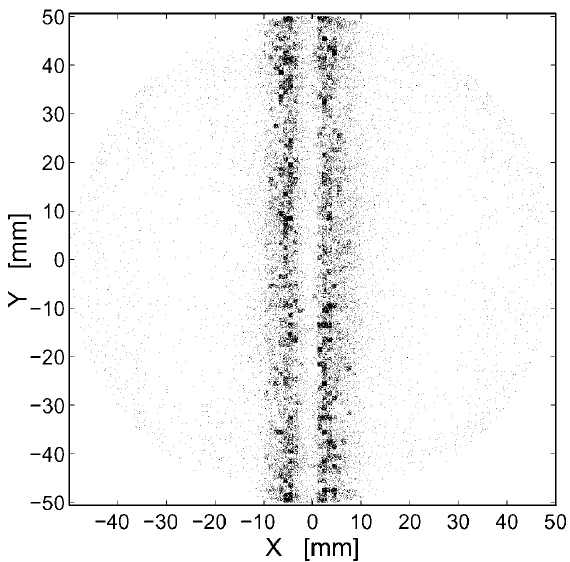
FIG. 8. Electron-cloud distribution in the dipole magnet.